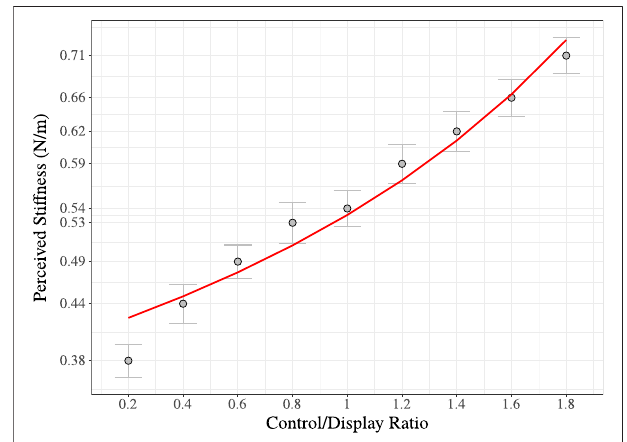
FIGURE 4 | Data from experiment 1 on perceived stiffness by C/D ratio (gray dots), and the corresponding fi tting with Eq. 5 by C/D ratio (R =